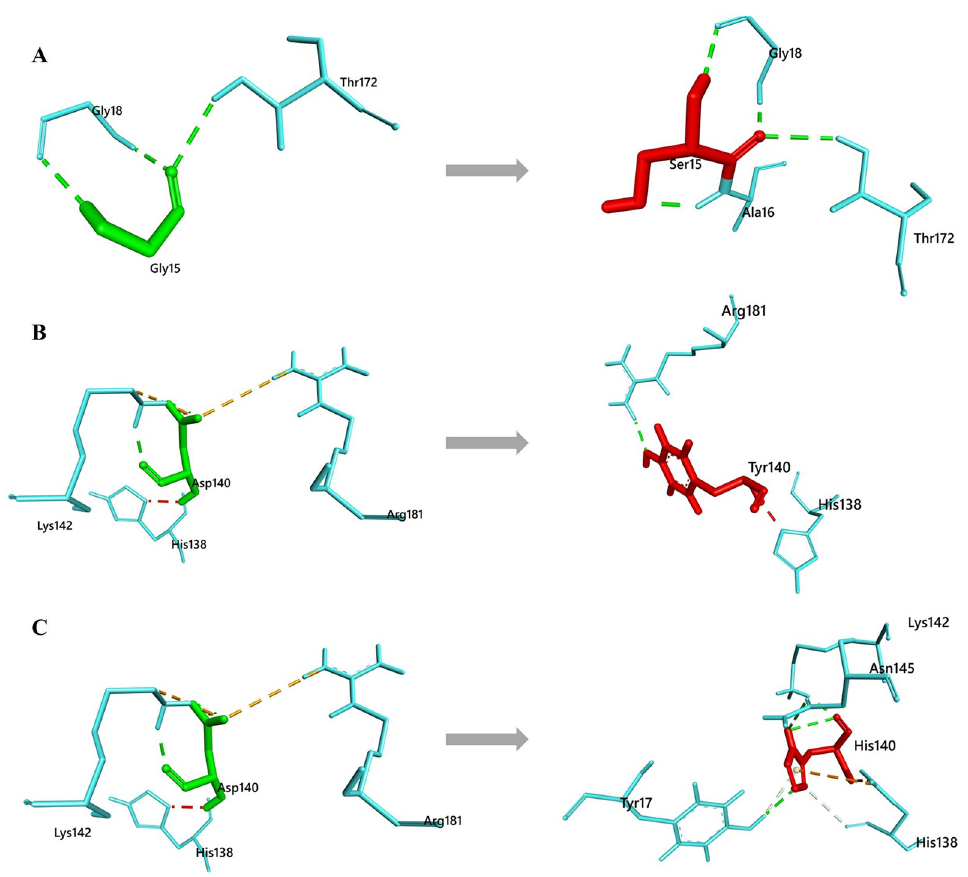
Fig 7. Non-bonding residual interaction analysis of Native and Mutant CDK4 proteins (A) Native Gly15 and mutated Ser15 (B) Native Asp140 and mutated Tyr140 and (C) Native Asp140 and mutated His140. The interacting bonds are displayed as: Conventional hydrogen bonds/ Carbon hydrogen bonds as green line, pi-pi stack/pi-alkyl as pink lines, Salt bridge/ attractive charge/ electrostatic as brown